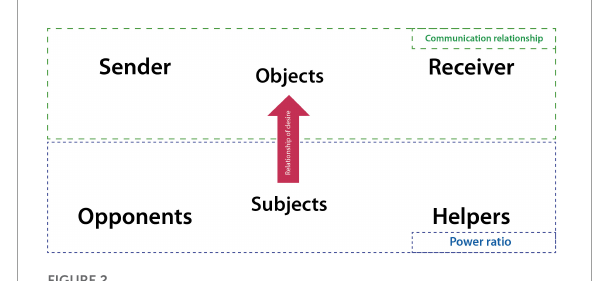
FIGURE2 Based on Greimas (1987) Actantial Model, the Project developed an analysis of journalistic accounts from the understanding and actantial location vis-à-vis peace narratives. Source: CAPAZ